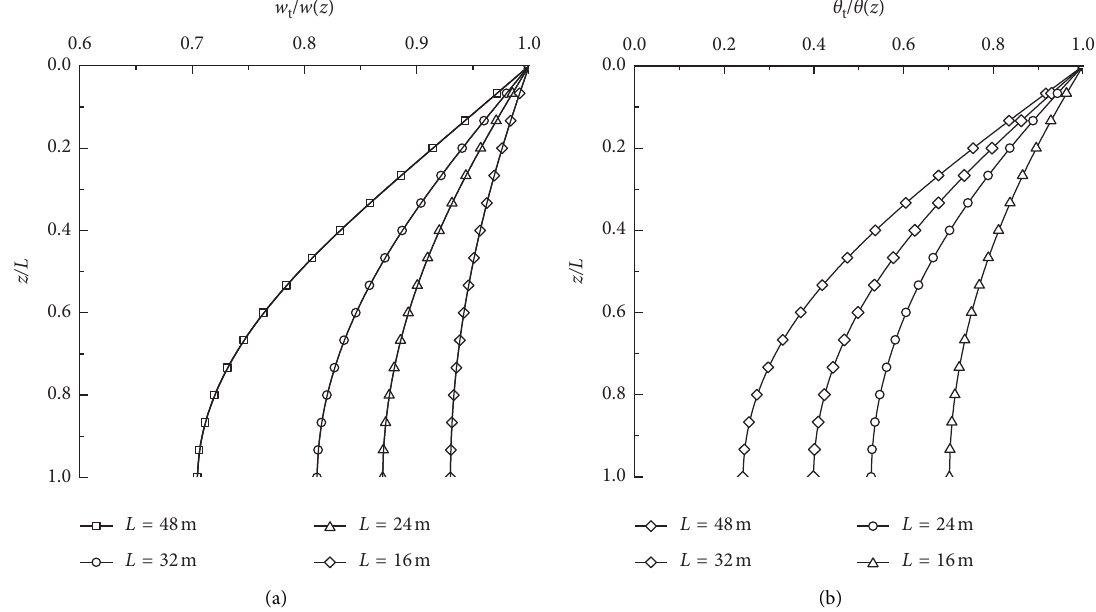
Figure 10: Influence of L/D on the pile shaft displacement. (a) Settlement of the pile body under the T ⟶ V loading path. (b) Torsion angle of the pile body under the V ⟶ T loading